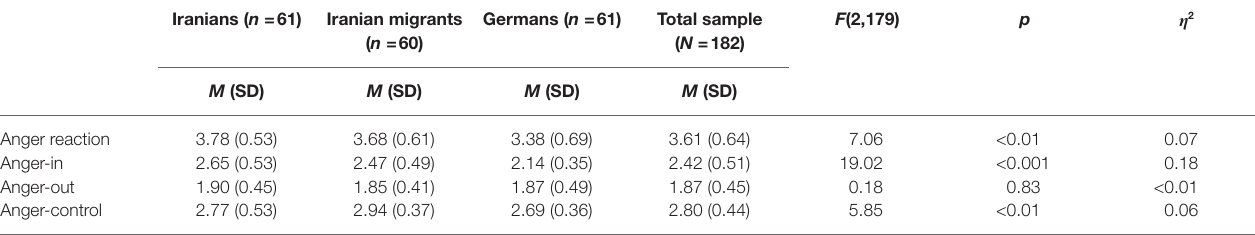
TABLE 3 | Means, standard deviations, and one-way analyses of variance in anger-reaction, anger-control, anger-out, and anger-in. Iranians ( n = 61) Iranian migrants ( n = 60)